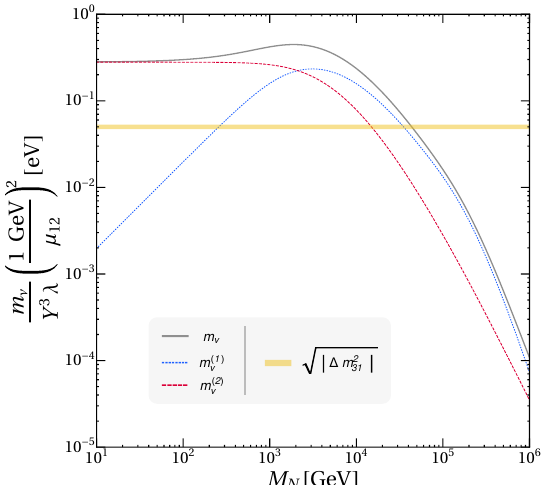
Figure 11 . Neutrino mass scale m (cid:23) (solid line) for the diagram of (cid:12)gure 10 with respect to the mass of N L . The rest of the masses are (1) TeV. The contributions coming from both F ( a ) , O see (4.2), has been separated (dashed lines). The atmospheric mass scale (yellow line) is plotted for comparison. See text for details.